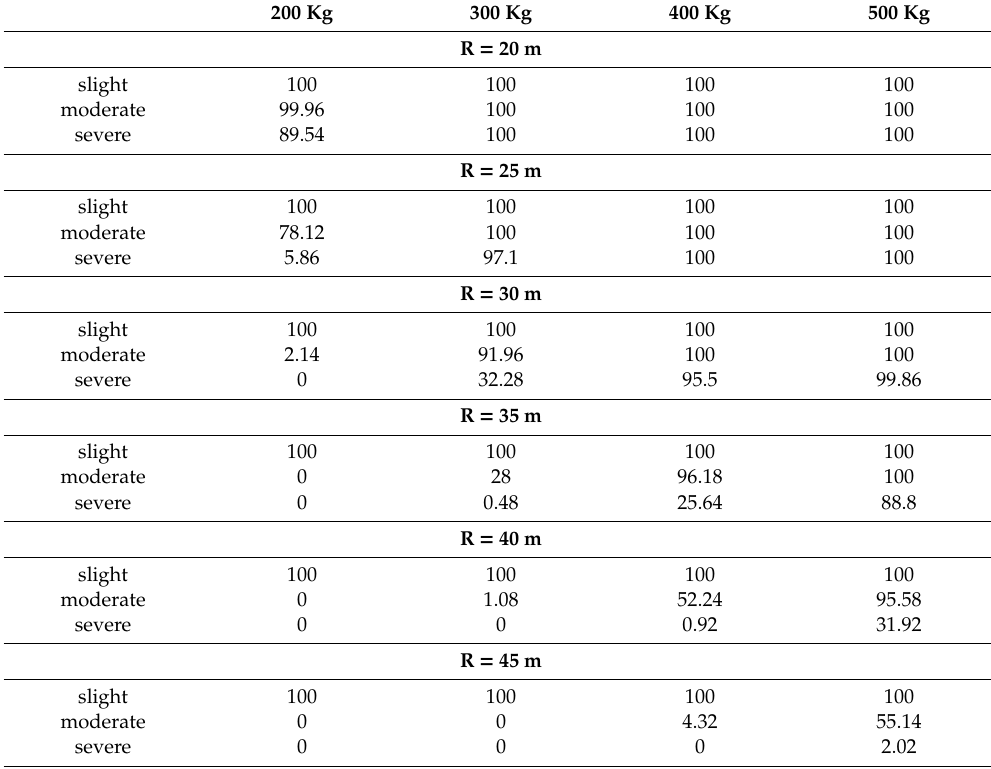
Table 10. Percentage probability of thresholds exceedance for Cagliari